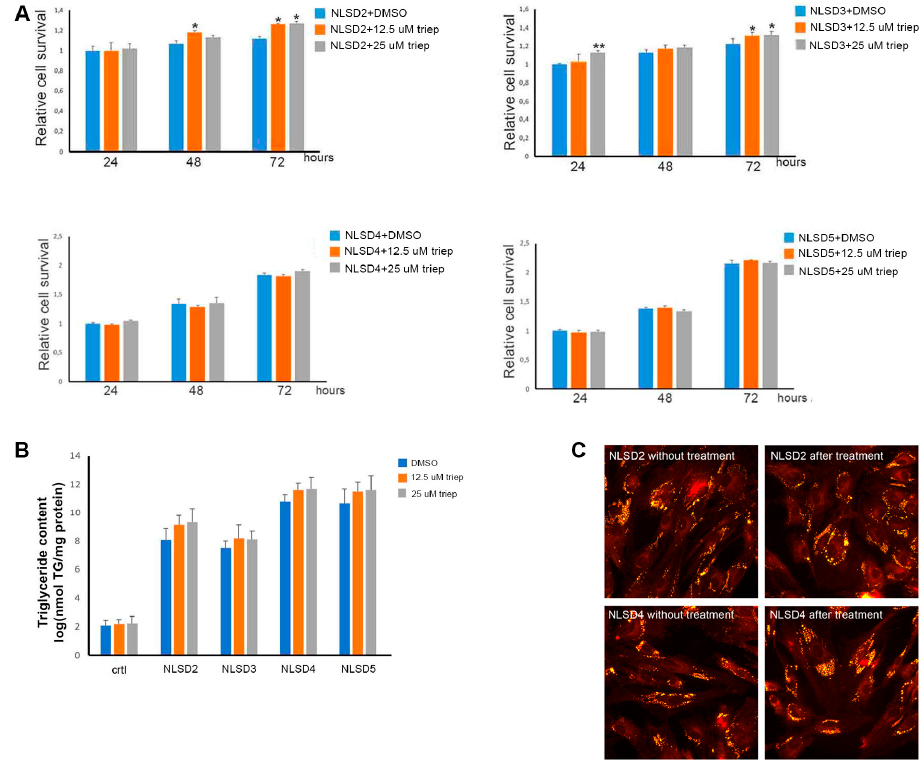
Figure 3. Effect of triheptanoin on cell proliferation and neutral lipid metabolism. ( A ) Relative cell survival measured in NLSDM fibroblasts treated with 12.5 and 25 µM triheptanoin. Histograms represent basal cell viability obtained from 3 independent experiments. Data are presented as mean ± SD. Statistical significance was evaluated through Student’s t -test. * p ≤ 0.05, ** p ≤ 0.001; ( B ) quantification of TAG amount in NLSDM fibroblasts treated with 12.5 and 25 µM triheptanoin. Histograms represent TAG content from 3 independent experiments. Data are presented as mean ± SD; ( C ) NLSDM fibroblasts before treatment and cultured with 25 µM triheptanoin for 9 days and stained with Nile Red. Magnification: 40×.